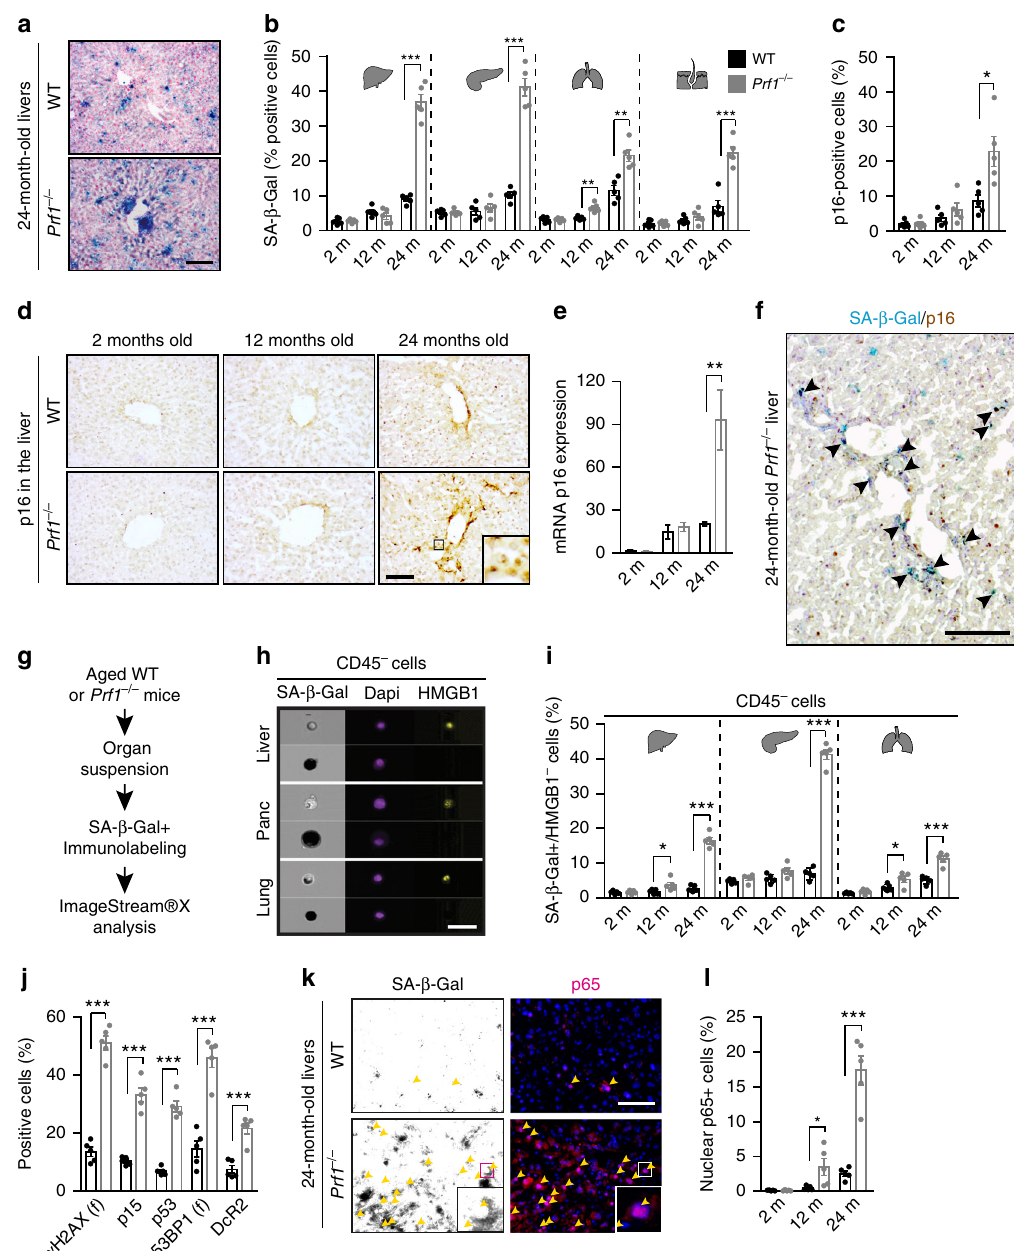
Fig. 1 Old Prf1 − / − mice accumulate more senescent cells then old WT mice. Cohorts of Prf1 − / − and wild type (WT) C57BL/6 female mice at the age of 2, 12, and 24 months were sacri fi ced and their livers, pancreas, lungs, and skin were examined for the presence of senescent cells. a SA- β -Gal activity representative frozen sections of livers from 24-months-old mice. Scale bar, 100 µ m. b Quanti fi cation of cells with marked SA- β -Gal activity, based on Nuclear Fast Red counterstaining, in liver, pancreas, bronchial epithelia, and skin epidermis. ( n = 5 mice per group). c Percentages of cells stained positively for p16 in the liver. Values are means± SEM, ( n = 5 mice per group). d Representative images of IHC staining for p16 on liver frozen section. Scale bar, 100 µ m. e Real-time qPCR analysis for expression of p16 in livers. Values are means ± SEM, ( n = 5 mice per group). f Representative image of SA- β -Gal activity combined with IHC staining for p16 on liver frozen section from 24 old Prf1 − / − mice. Scale bar, 100 µ m. g Scheme of examination of senescence by ImageStreamX. h Representative ImageStreamX images of CD45 − negative cells derived from indicated organs that were stained for HMGB1 and SA- β - Gal. Scale bar, 50 µ m. i Quanti fi cation of CD45 − /SA- β -Gal + /HMGB1 − population in each organ, as analyzed in ( h ). ( n = 5 mice per group). j Percentages of cells stained positively for γ H2AX, p15, p53, p53BP1, and DcR2 in livers from old mice. ( n = 5 mice per group). k Immuno fl uorescence staining for p65 (pink) in SA- β -Gal + cells (indicated by arrows in black/white photos) in livers from old mice. Scale bar, 50 µ m. l Percentages of nuclei positive for p65 in livers. For all graphs, values are means± SEM, ( n = 5 mice per group). Student ’ s t -test was used for all comparisons between Prf1 − / − and WT female mice (* P < 0.05, ** P < 0.01, *** P <